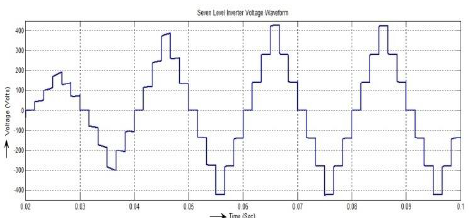
Figure 15 . The Input Voltage waveform of 7-Level Inverter